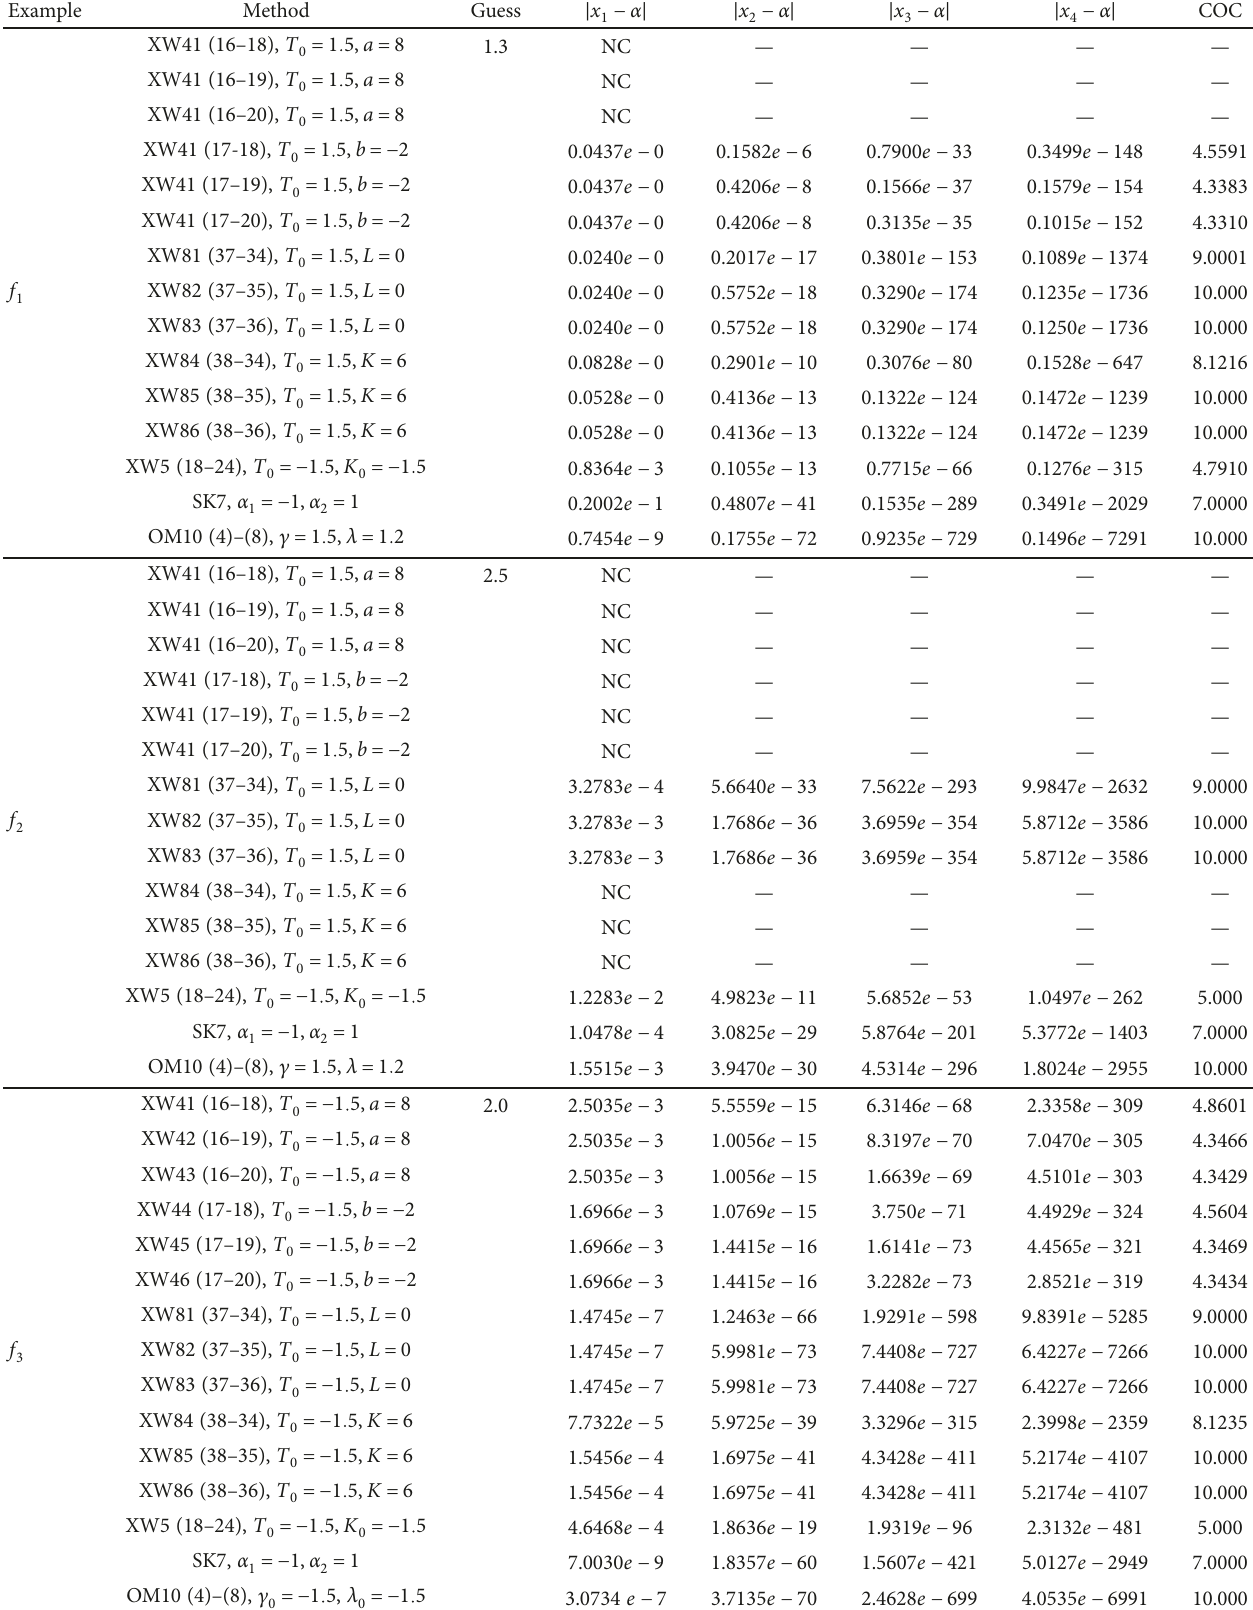
Table 2: Numerical comparison of bi-parameter with memory